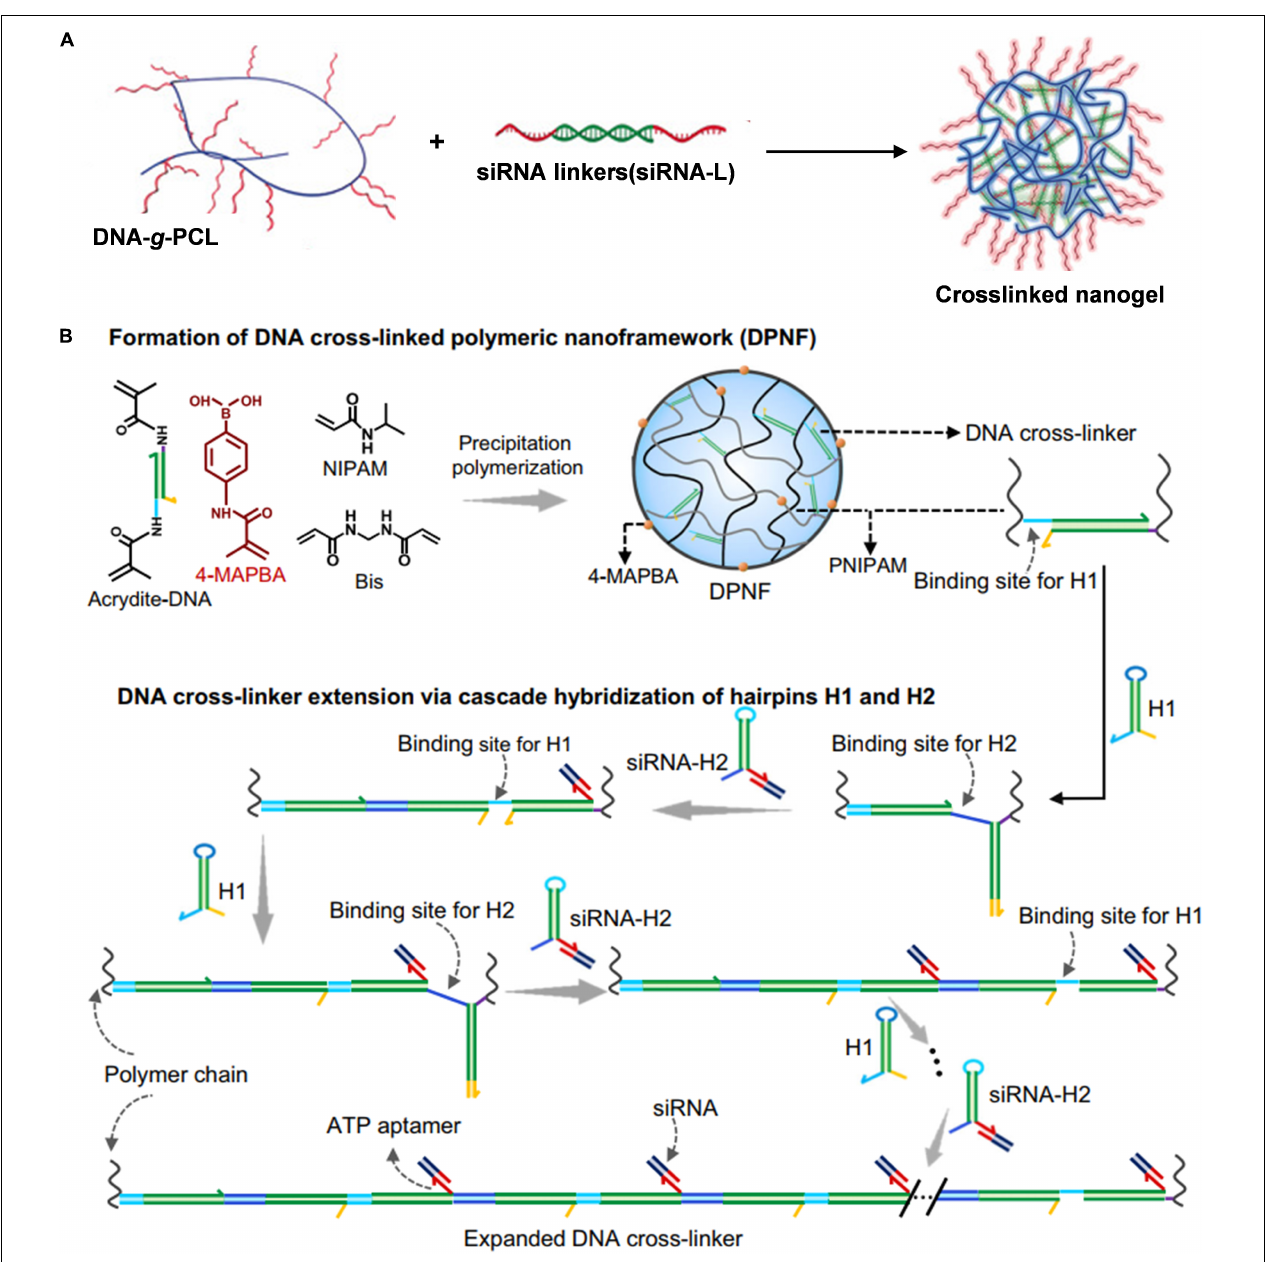
FIGURE 4 | DNA-polymer nanoassembly for efficient siRNA delivery. (A) Crosslinked nucleic acid nanogel for effective siRNA delivery. Adapted with permission from Ding et al. (2018). Copyright 2018, Wiley-VCH. (B) Cascade hybridization of hairpin DNA in polymeric nanoframework for precise siRNA delivery. Adapted with permission from ref (Li et al., 2021). Copyright 2021, Nature Publishing